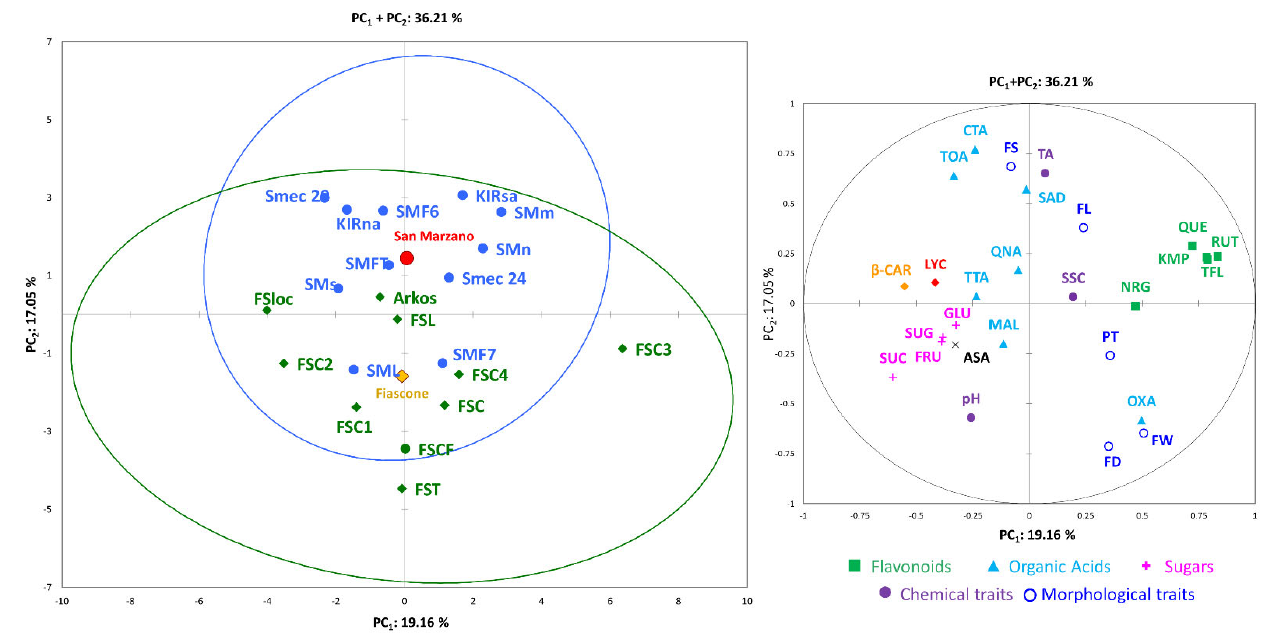
Figure 4. Loading plot of the first (PC 1 ) and second (PC 2 ) principal components showing the variation for 27 morpho-agronomic and phytochemical traits scored in 21 tomato accessions. ‘Re Fiascone’ and ‘San Marzano’ are indicated with different coloured symbols. On the right are indicated the distribution of the traits scored. The direction and distance from the centre of the biplot indicate how each OTU contributes to the first two components. The different category of traits is indicated using different colour codes as following as indicated in the legenda at the bottom. Beta-carotene and trans -lycopene are indicated with orange and red rhombus, respectively. Ascorbate is indicated by black, ‘x’ Trait acronyms are listed in Table 3.